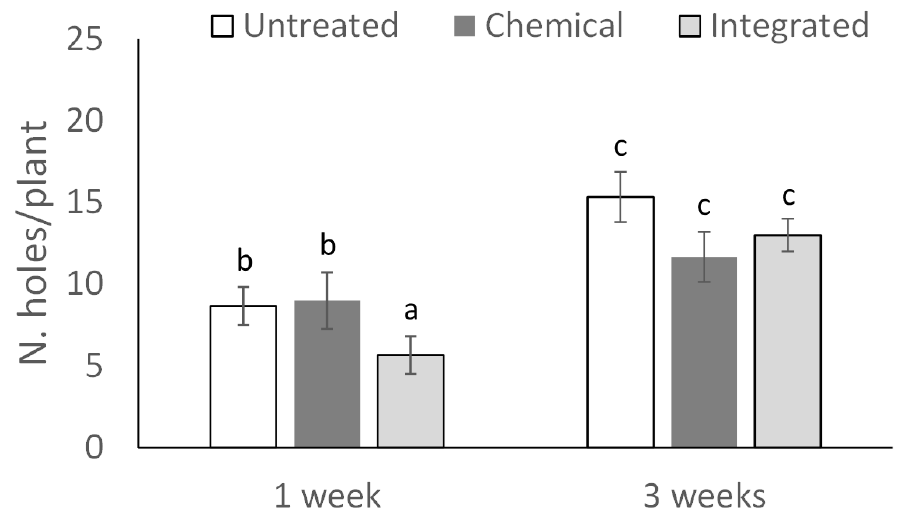
Figure 7. Density (mean ± SD) of penetrating holes of O. nubilalis larvae assessed on treated (chemical and integrated) and untreated plots, one and three weeks after applications of Btk (BioBit) in the integrated plots. Different letters above bars indicate significant differences among means (ANOVA Mixed Proc., p < 0.05).